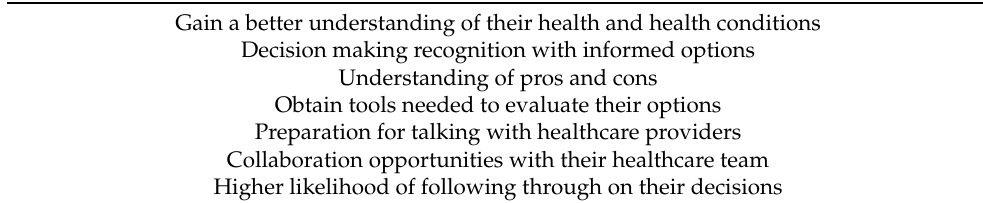
Table 2. Patient Benefits from Shared Decision